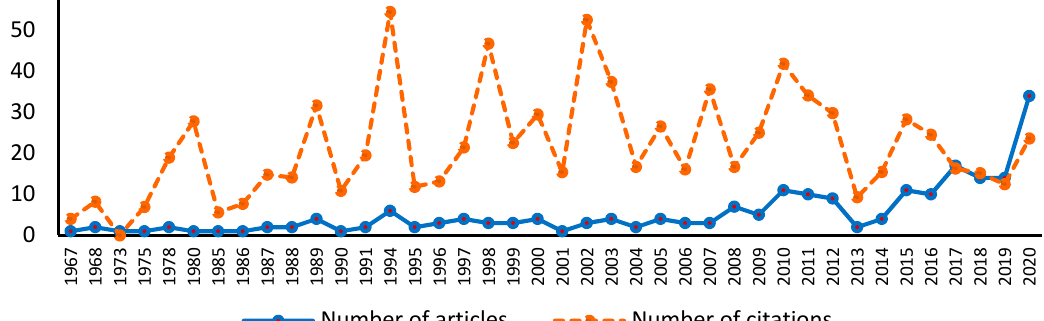
Figure 3. The number of articles and number of citations according to year.